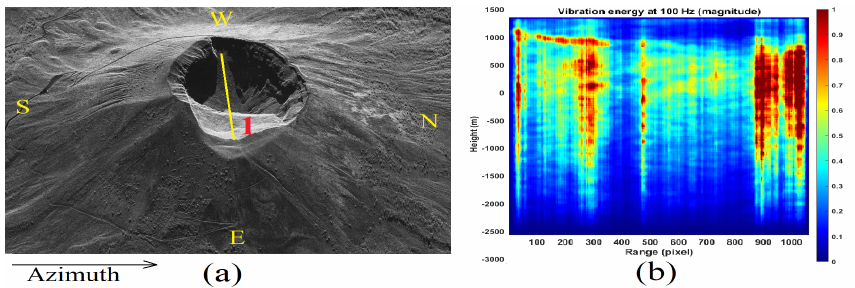
Figure 7. Range-line echographic tomography result (magnitude). ( a ) SLC SAR image (in magnitude). ( b ) Tomographic result (in magnitude).